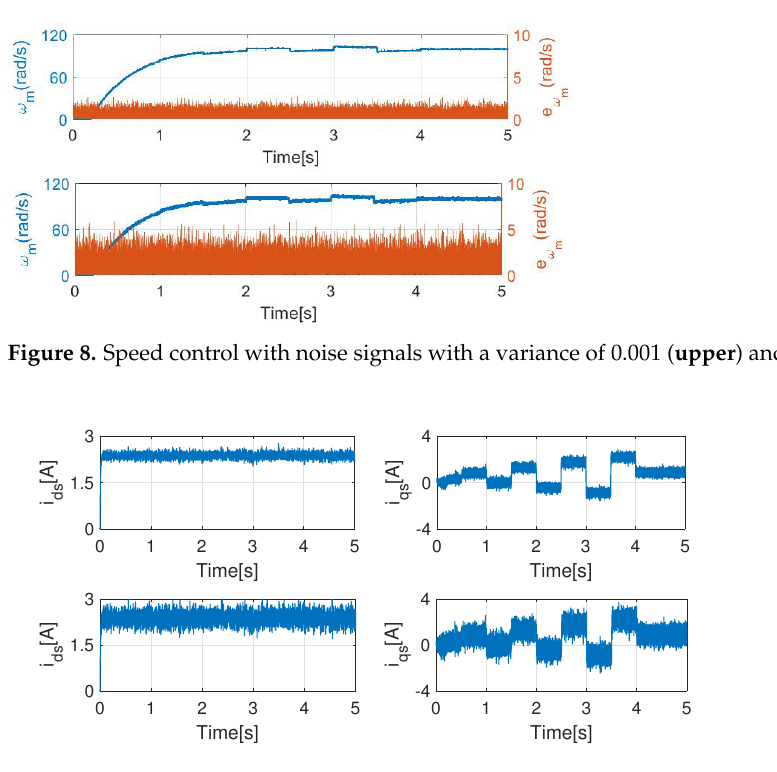
Figure 9. Current curves with noise signals with a variance of 0.001 ( upper ) and 0.005 ( bottom ). From the current point of view, the noise amplitudes have slightly increased, but this has no effect on the control ability. The biggest difference can be observed in the error amplitudes, which are shown in Table 1. With noise signal variance of 0.001, the mean of the error increased by 0.5034 rad/s (2721%), with a variance of 0.005 the increase is 1.125 rad/s (2698%). The percentage increase may mean that applying noise to the speed signal would cause a fatal error; however, this is not the case. The error percentage compared to the full scale of the signal remains under 6% as the maximum column shows, which is fully acceptable in this case. Table 1. Observed speed signal error